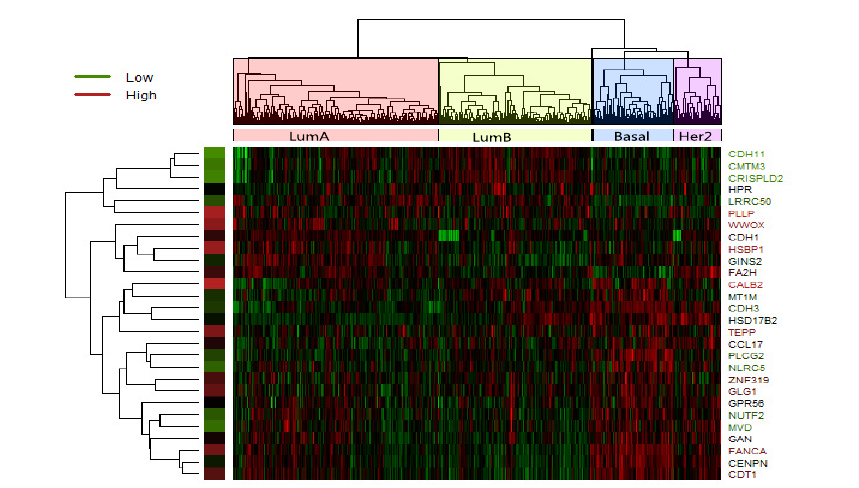
Figure 2. Heatmap of expression values of 28 most significant differently expressed gene in LumA-subtype. Clustering method on expression values was used to generate the heatmap. There are clear clusters of genes for the four tumor subtypes.